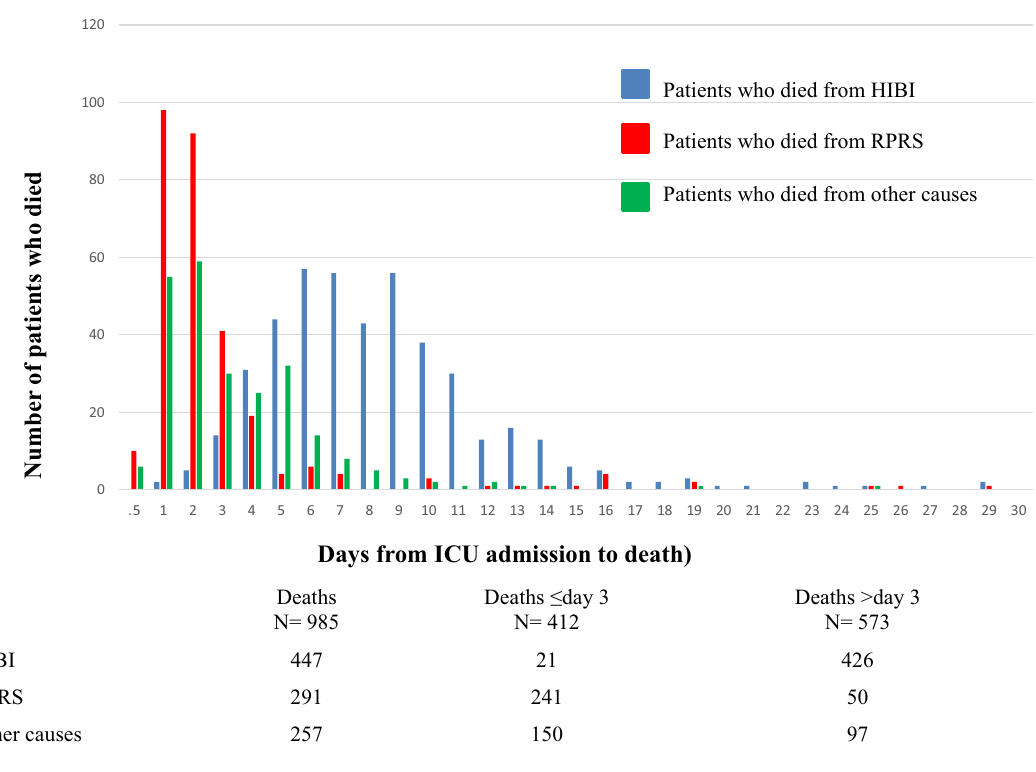
whereas brain damage develops over time, with the possible participation of secondary insults 30,31 . Our compet- ing-risks approach took into account the high early mortality from RPRS in patients with high CAHP scores. Our findings suggest that the CAHP score may be useful to constitute uniform populations for future trials focus on post CA selecting the patients most likely to benefit from interventions aimed at preventing either RPRS or HIBI. Thus, patients with high CAHP scores at ICU admission may be unlikely to derive benefit from neuro- protective treatments such as TTM, given their high risk of early death due to RPRS. According to Sunde et al.,